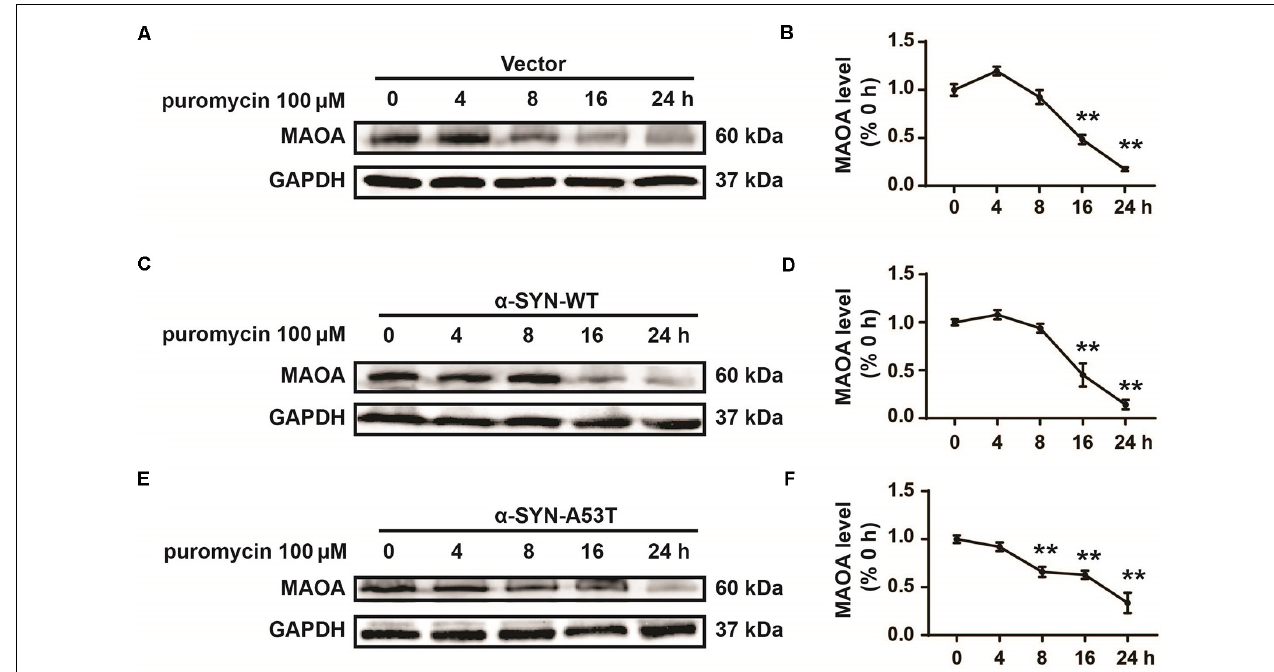
FIGURE 3 | Effects of overexpression of α -SYN WT and α -SYN A53T on MAOA degradation. The protein level of MAOA was detected using Western blot in α -SYN (WT and A53T) stably overexpressed and control (Vector) cells cultured with puromycin (100 µ M) for 0, 4, 8, 16, and 24 h (A–F) . Data were expressed as mean ± SEM. ** p < 0.01 vs. the same cells at 0 h point, n =